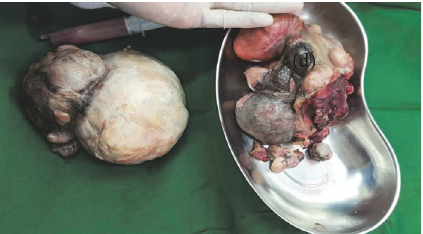
Figure 2: Matted Necrosed Myomas and the uterus (d) after extraction from the subtotal